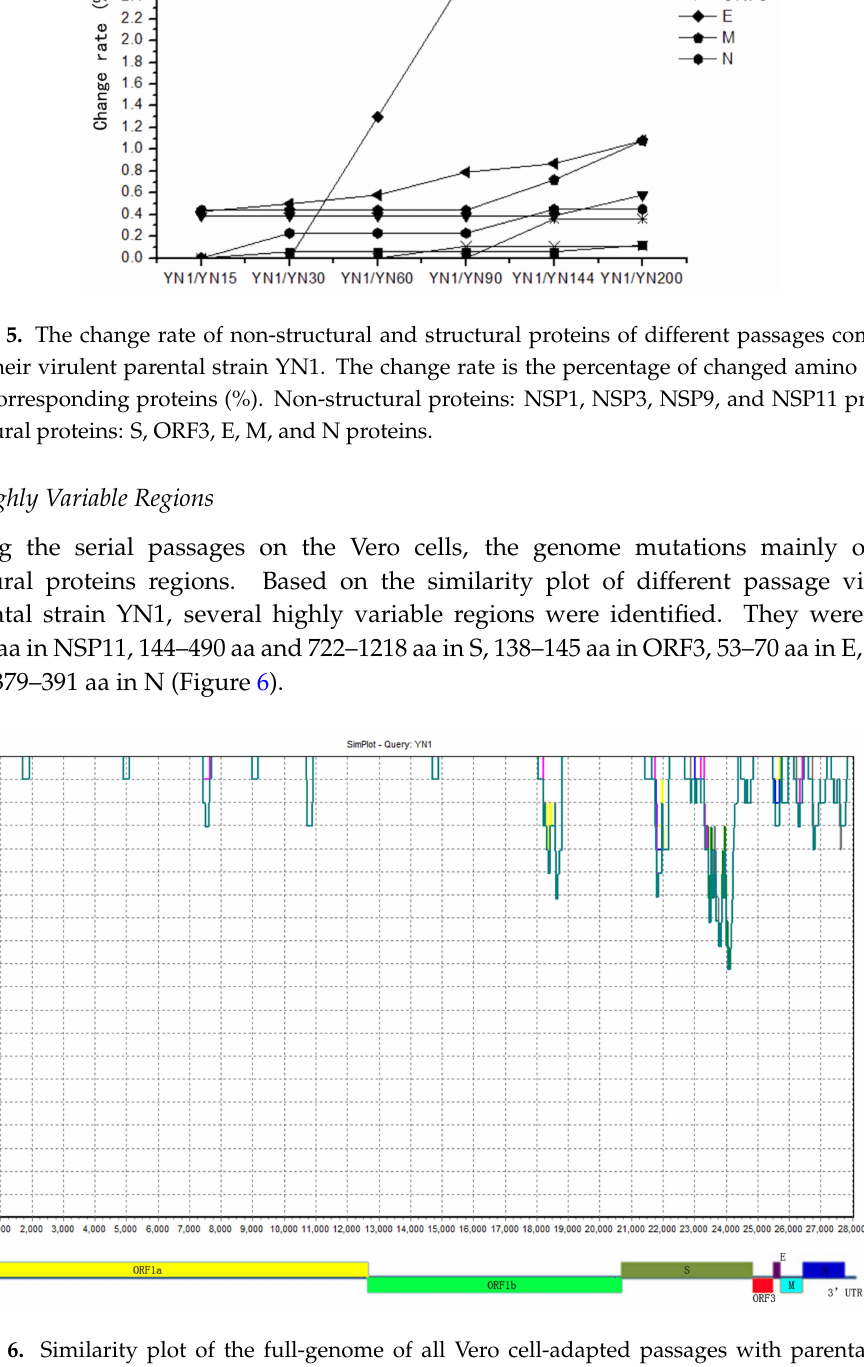
Figure 6. Similarity plot of the full-genome of all Vero cell-adapted passages with parental YN1. The similarity plot was constructed using the two-parameter (Kimura) distance model with a sliding window of 200 bp and step size of 20 bp. The vertical and horizontal axes indicate the percent nucleotide similarity and nucleotide position (bp) in the graph, respectively.